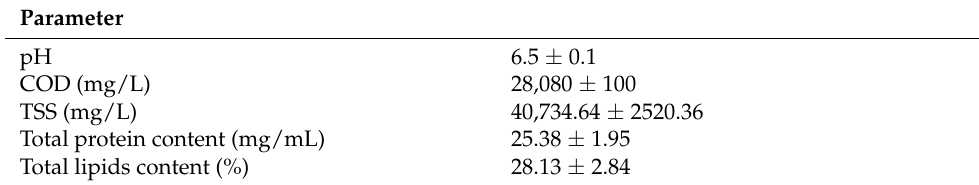
Table 1. Characterisation of sardine cooking